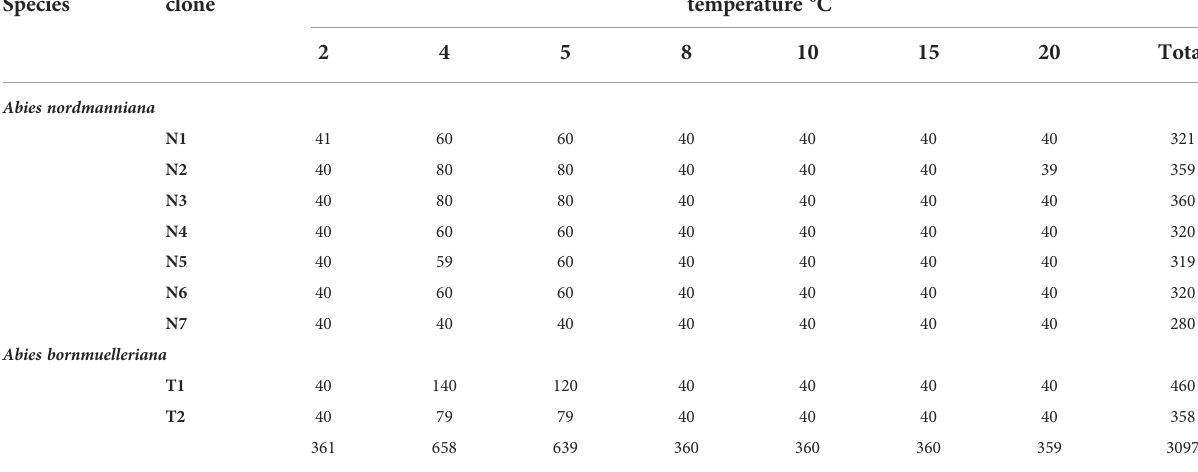
TABLE 1 Overview of clones, number of embryos and treatments at the start of germination at different temperatures. Species